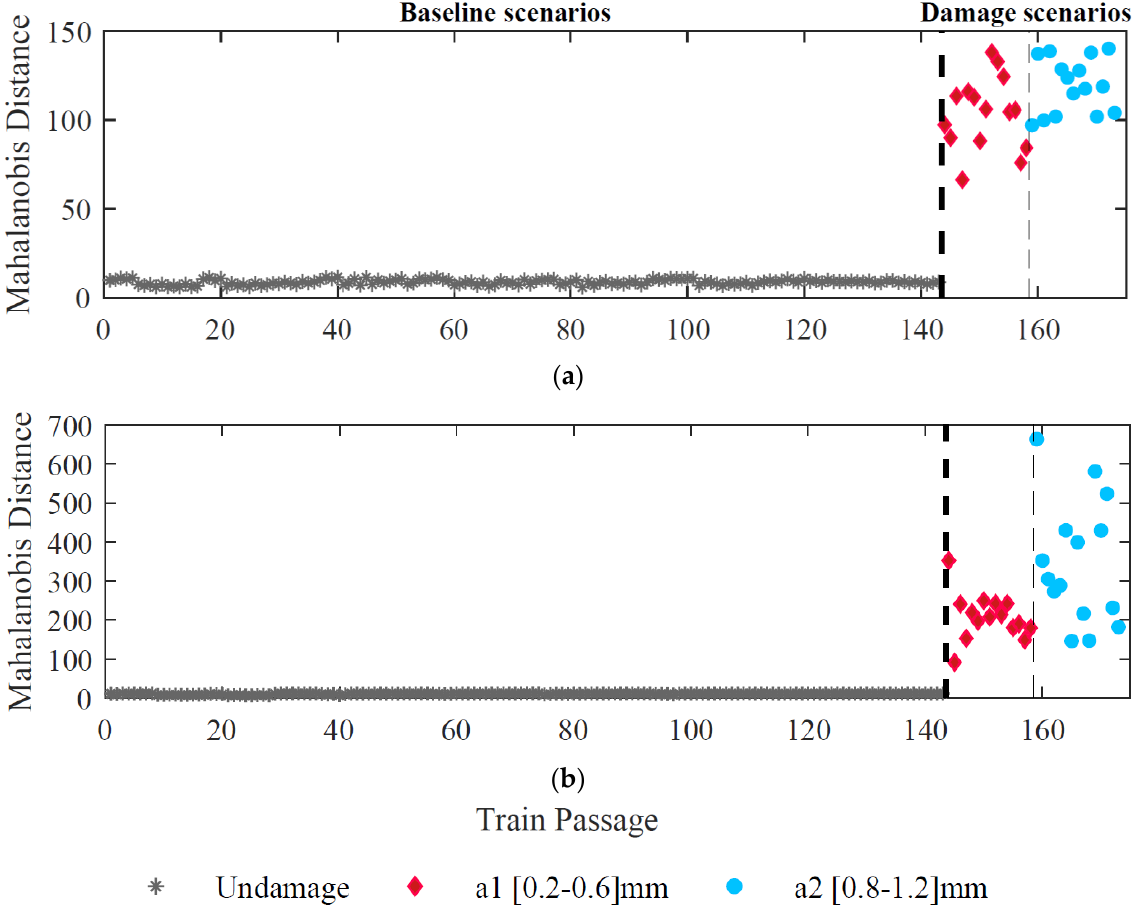
Figure 14. Feature normalization for sensor 1, ( a ) ARX – PCA – based feature 3, ( b ) ARX – PCA – based feature 36, ( c ) CWT – double – PCA-based feature 140, ( d ) CWT – double – PCA – based feature 266.